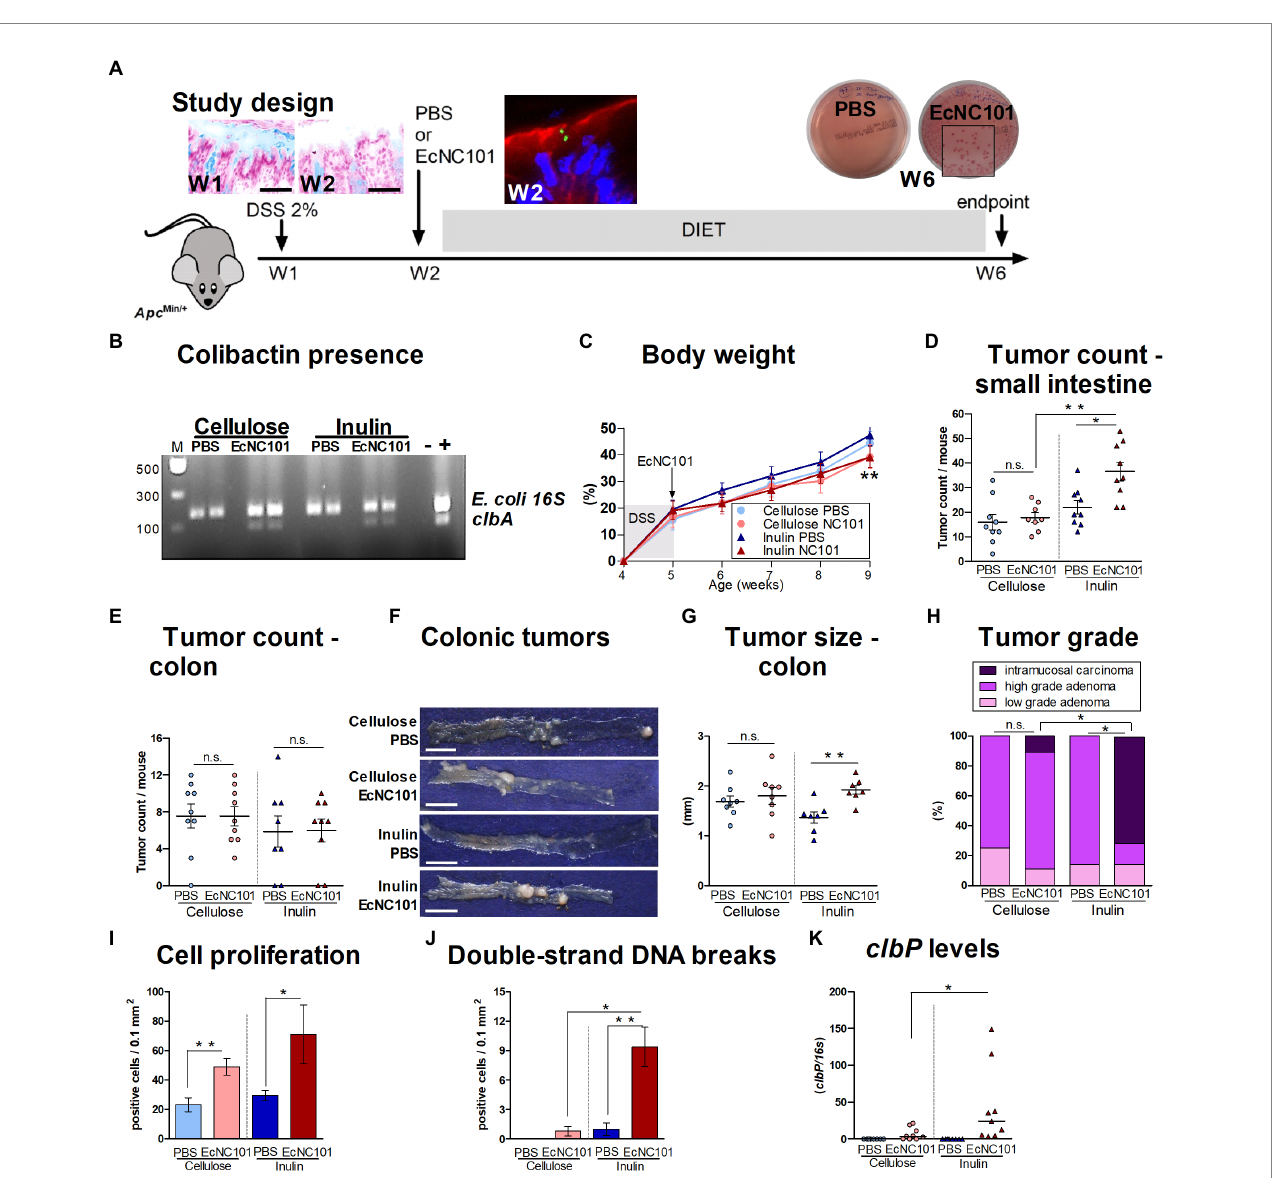
FIGURE 1 Carcinogenicity in Apc Min/+ mice colonized with EcNC101 and fed an inulin supplemented diet. (A) Alcian blue staining of the colonic mucus layer in Apc Min/+ mice after treatment with 2% DSS in drinking water for a week (Week 1, W1). Mice were fed diets supplemented with 10% cellulose or 10% inulin and received oral gavage with PBS or 10 8 CFU of EcNC101 at W2. EcNC101 FbFP fluorescence observed 24 h after the gavage by confocal microscopy (F-actin: red, DAPI: blue). At the end of the experiment (W6), fecal homogenates were cultured on MacConkey agar for Enterobacteriaceae detection. (B) EcNC101 colonization assessed by PCR amplification of the clbA gene. (C) Body weight (mean ± SEM; ** p < 0.01 between the inulin groups, repeated-measure ANOVA). (D,E) Tumor count in (D) small intestine and (E) colon. (F) Representative images of colonic tumors (left side: cecum, right side: rectum), scale bar = 1 cm. (G) Tumor size in the colon. (H) Colonic tumor grades (Chi-square Test). (I) Quantification of Ki-67-positive cells per healthy mucosa site ( N = 5 per group). (J) Quantification of γ -H2AX-positive cells per healthy colonic mucosa site ( N = 5 per group). (K) colibactin P gene by qPCR. n.s. non-significant; * p < 0.05, ** p < 0.01. ANOVA in between groups; N = 8–9 per